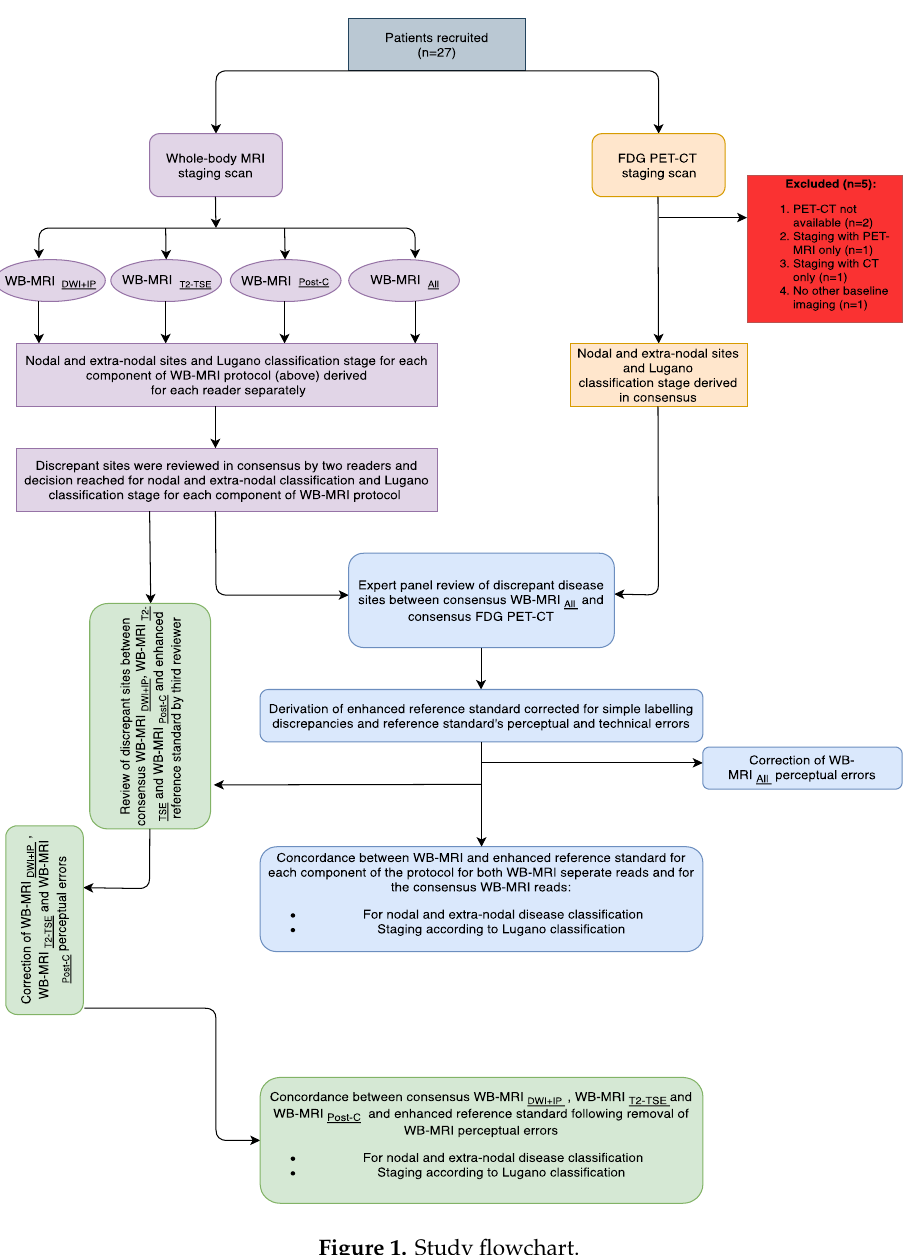
Figure 1. Study Figure 1. Study flowchart.